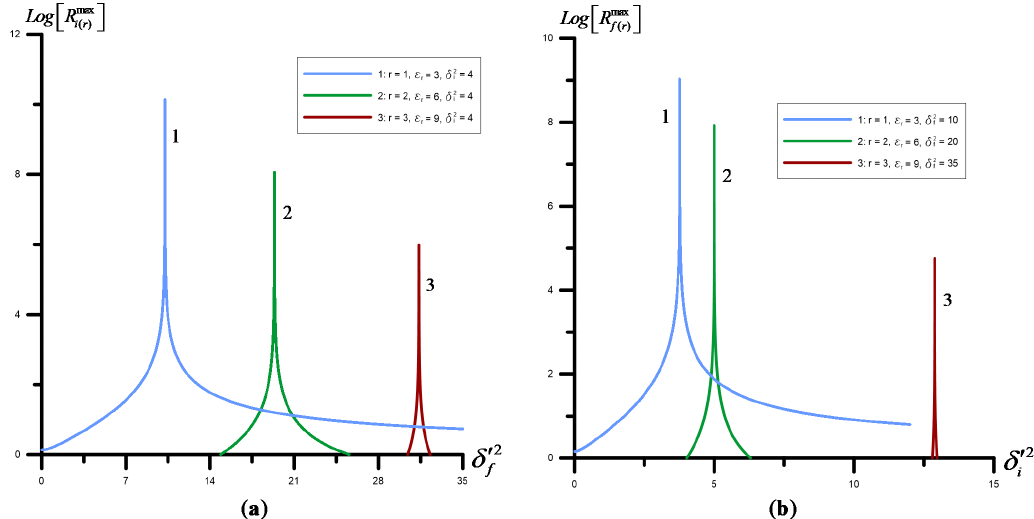
Figure 5. ( a ) Dependency of R max function on parameter δ (cid:48) 2 for the fixed value of the hard f i ( r ) gamma-quantum frequency. ( b ) Dependency of R max function on parameter δ (cid:48) 2 for the fixed value of i f ( r ) the hard gamma-quantum frequency. The figure consists of 1, 2, and 3 resonances from expression (91). The magnitude of the characteristic parameter— ε 1 = 3, the characteristic energy— E 1 = 100 MeV, the energy of the initial electron— E i = 300